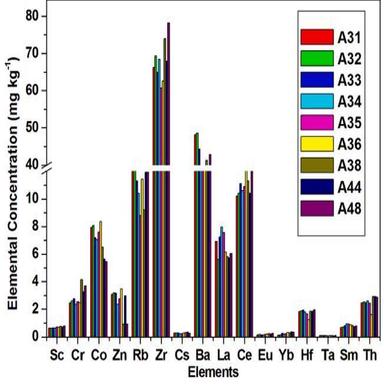
Trace elemental concentration variation in 9 different samples of Hyundai car brand.